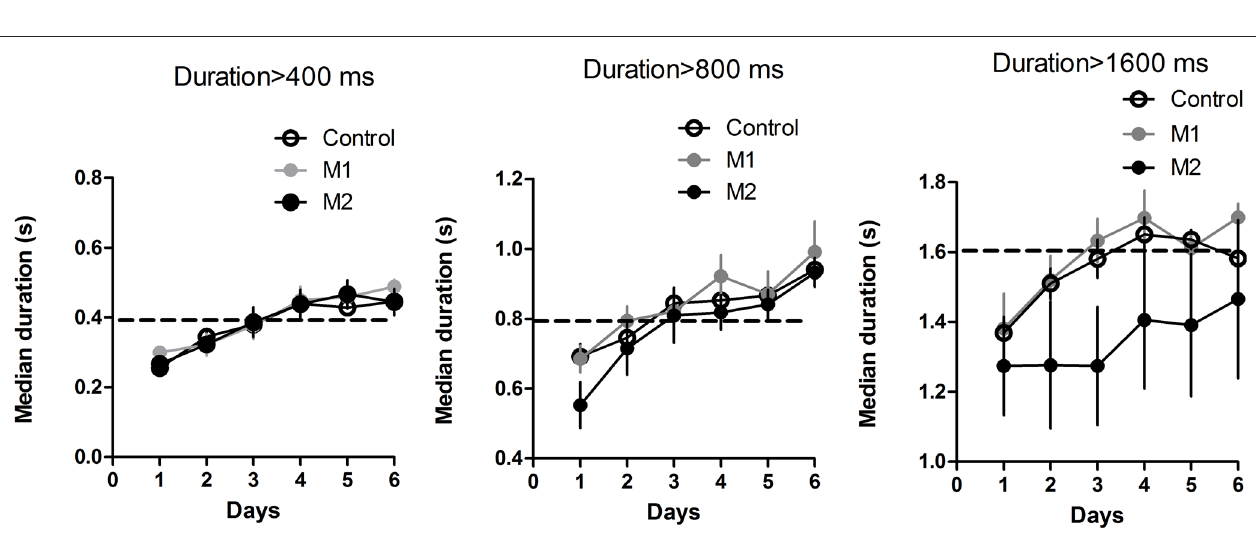
FIgure  | Temporal differentiation of lever pressing. The distributions of press durations are shown for the first and last sessions for each criterion duration. (A) 400 ms. (B) 800 ms. (C) 1600 ms.